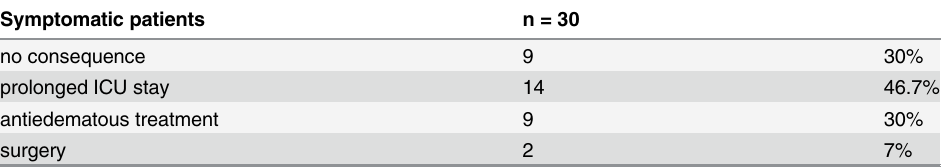
Table 3. Therapy in symptomatic patients.